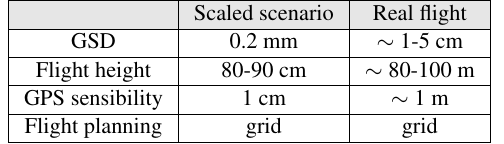
Table 2: Typical parameters used in the experiments. Note the (1 : 100) scale factor.